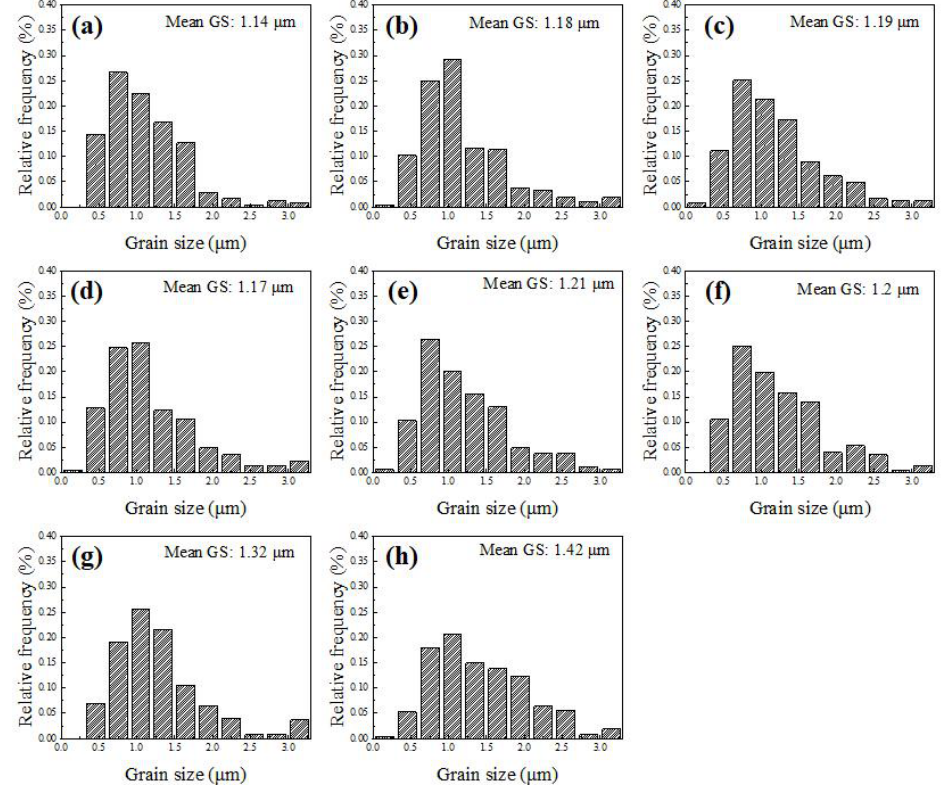
Figure 9. The grain size distribution in WC-13Co with different additions of Fe and C: ( a ) 0Fe-5.3C, ( b ) 1Fe-5.3C, ( c ) 2Fe-5.3C, ( d ) 3Fe-5.3C, ( e ) 4Fe-5.3C, ( f ) 2Fe-5.1C, ( g ) 2Fe-5.5C, ( h )